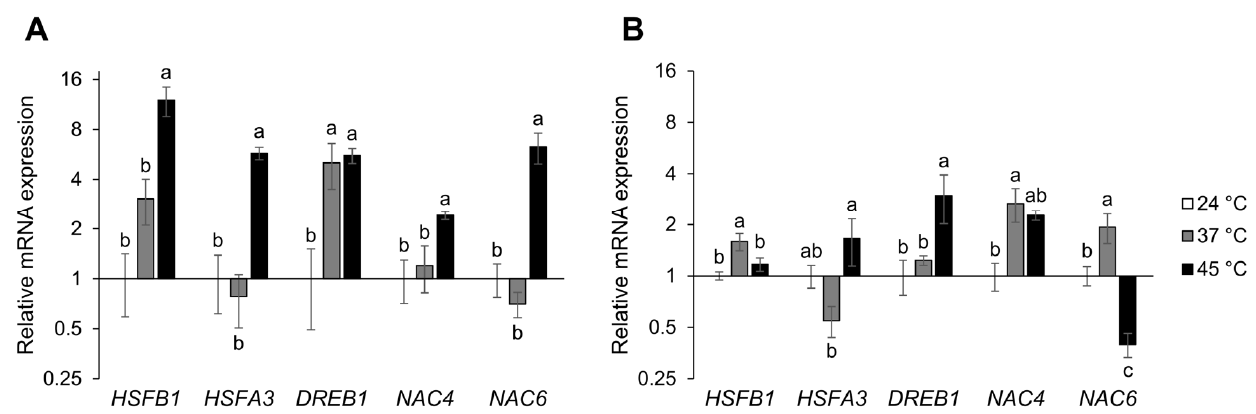
Figure 6. Gene expression analysis of tomato heat stress-related transcription factors. Seedlings ( A ) or adult plants ( B ) were either treated continuously at 37 °C or short exposed to 45 °C followed by recovery. Control plants were kept at 24 °C (Figure S1C,D). RNA was isolated from seedlings or young leaves harvested 24 h after the start of the treatment and expression of HSFB1 , HSFA3 , DREB1 , NAC4 and NAC6 genes was quantified. Each biological replicate consisted of 15 seedlings or leaves pooled from 6 adult plants. The data are expressed as ΔΔ Cq values on a log2 scale normalized to tomato genes ACT (for leaves), or EFI - α (for seedlings) and control (24 °C). The average of 3 biological replicates with standard deviations denoted by vertical bars are presented. Different letters indicate significant differences at p < 0.05 (Tukey’s test).